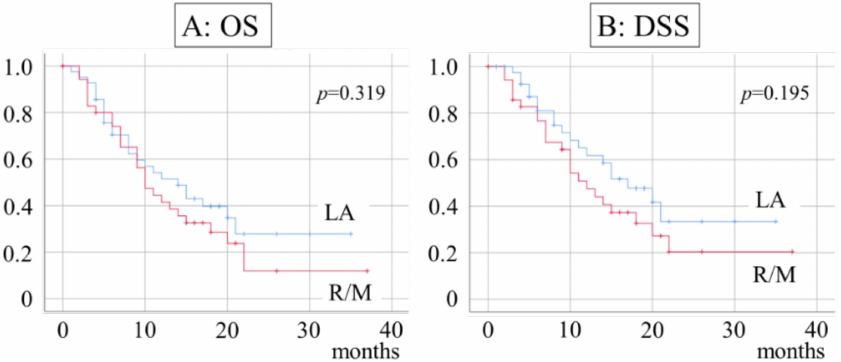
Figure 1. Survival rate and patient background. ( A ) Median OS duration is 14 months in LA